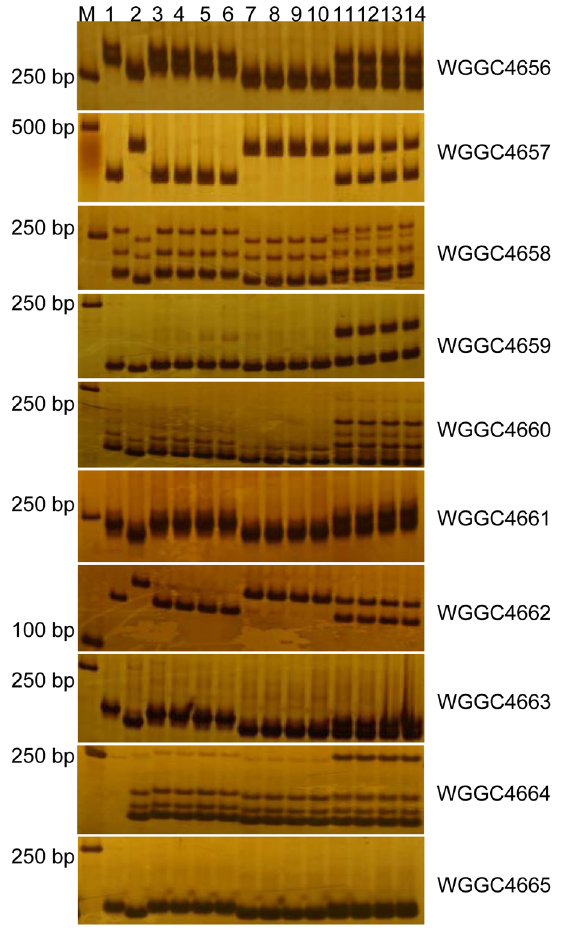
Figure 3. PCR amplification patterns of the markers WGGC4656, WGGC4657, WGGC4658, WGGC4659, WGGC4660, WGGC4661, WGGC4662,WGGC4663,WGGC4664 , and WGGC4665 in 8% non- denatured polyacrylamide gels. M: 2kb DNA marker. Lanes 1 and 2 are IW172 and Mo75, respectively, lanes 3–6 represent homozygous resistant plants, lanes 7–10 represent homozygous susceptible plants, and lanes 11–14 represent heterozygous resistant plants.